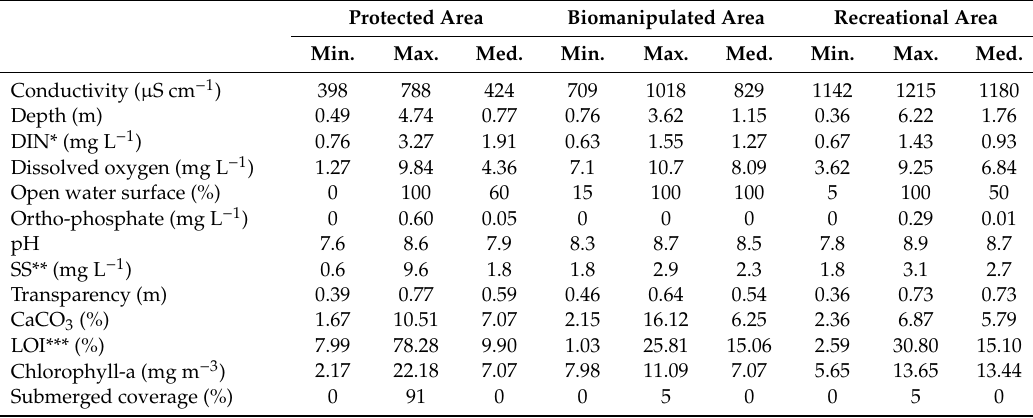
Table 1. The physical and chemical variables measured in the studied oxbow lake.